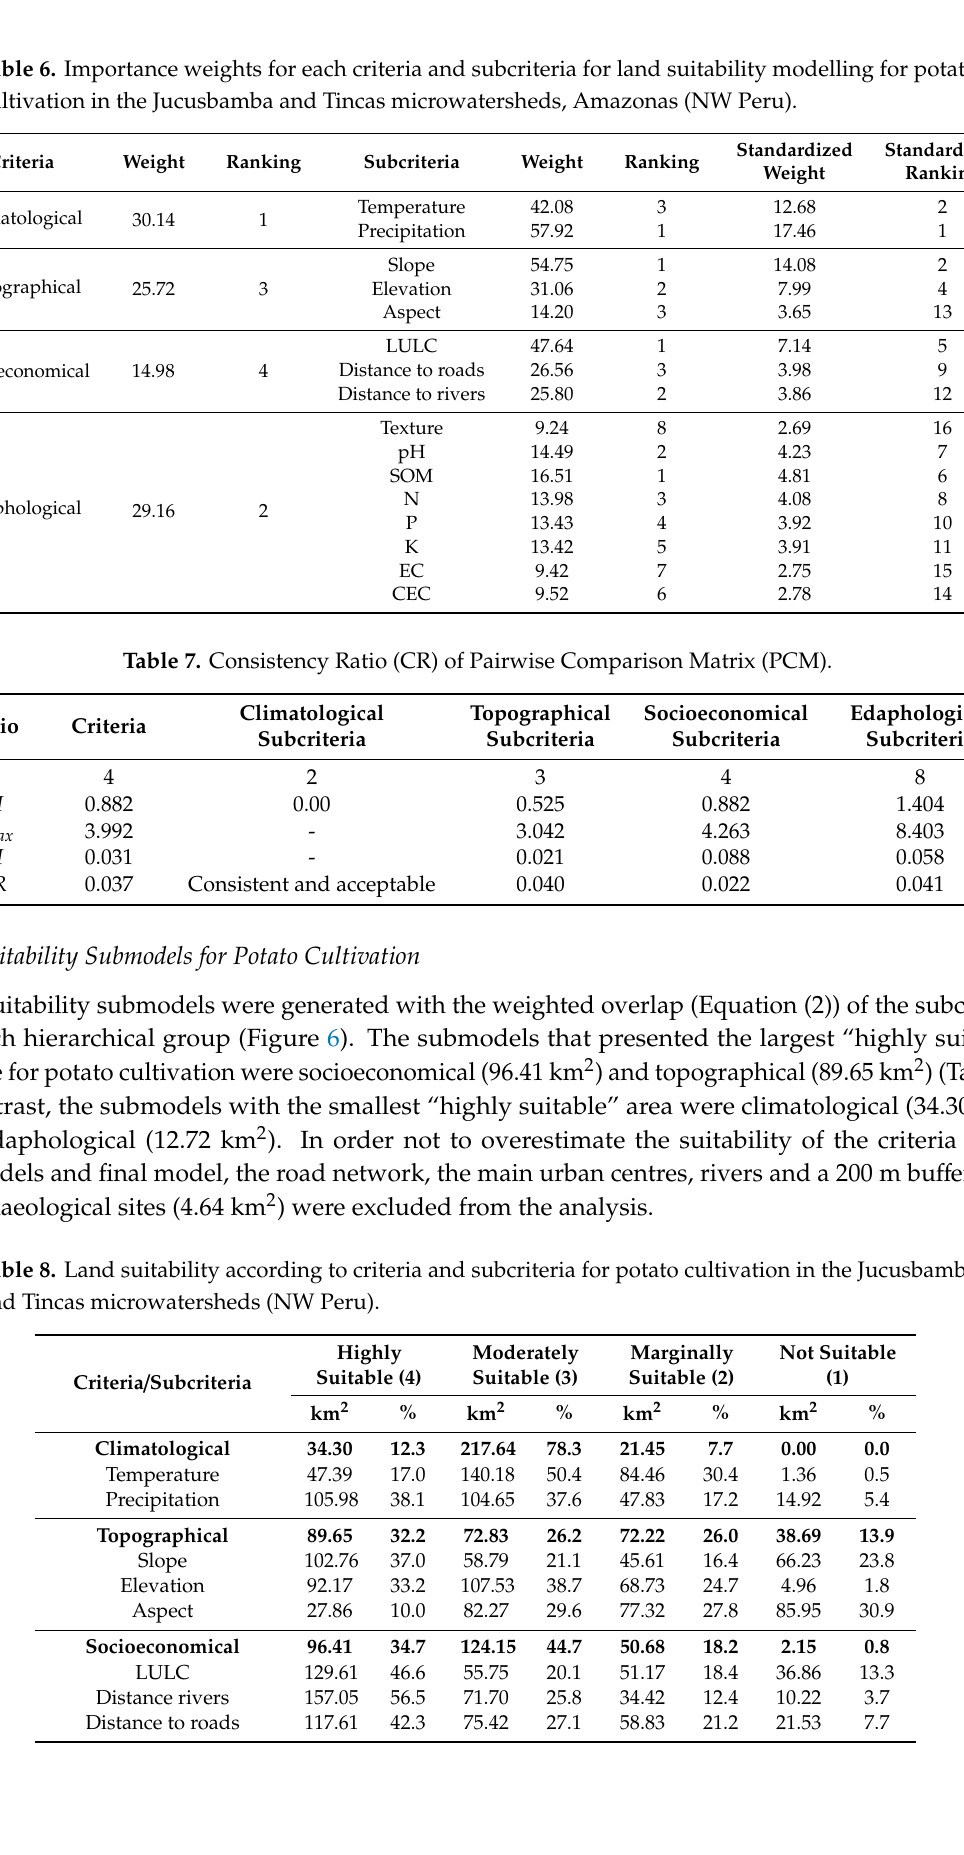
Standardized Standardized Weight Ranking